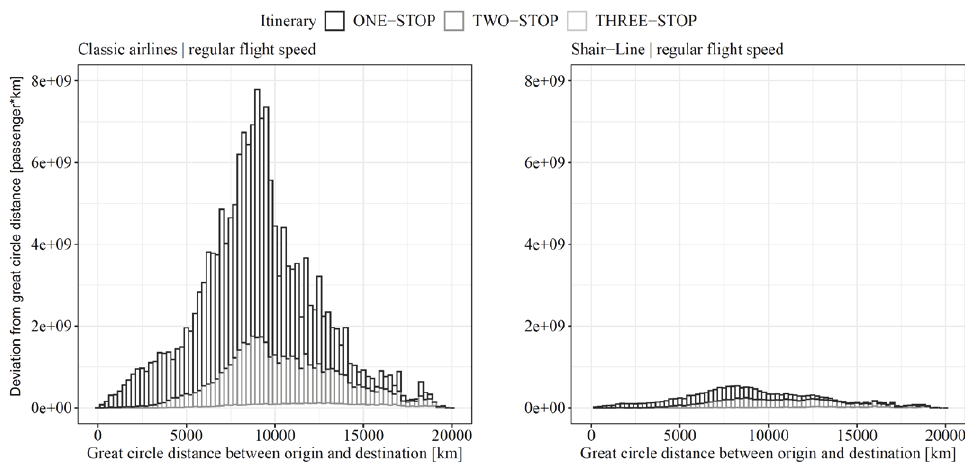
Figure 6. Deviation from orthodrome distances for passenger itineraries over a combined length of 4,000 km